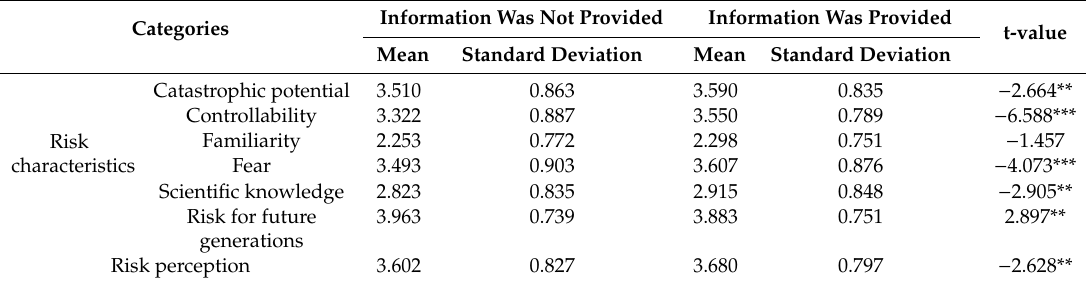
Table 3. Di ff erences in risk characteristics / perception based on the provision of risk response guideline